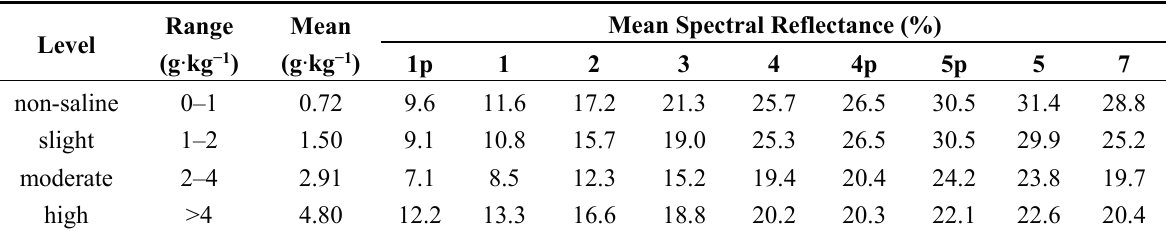
Table 3. Descriptive statistics of soil salinity and ALI-convolved field spectra for soils at different saline levels.